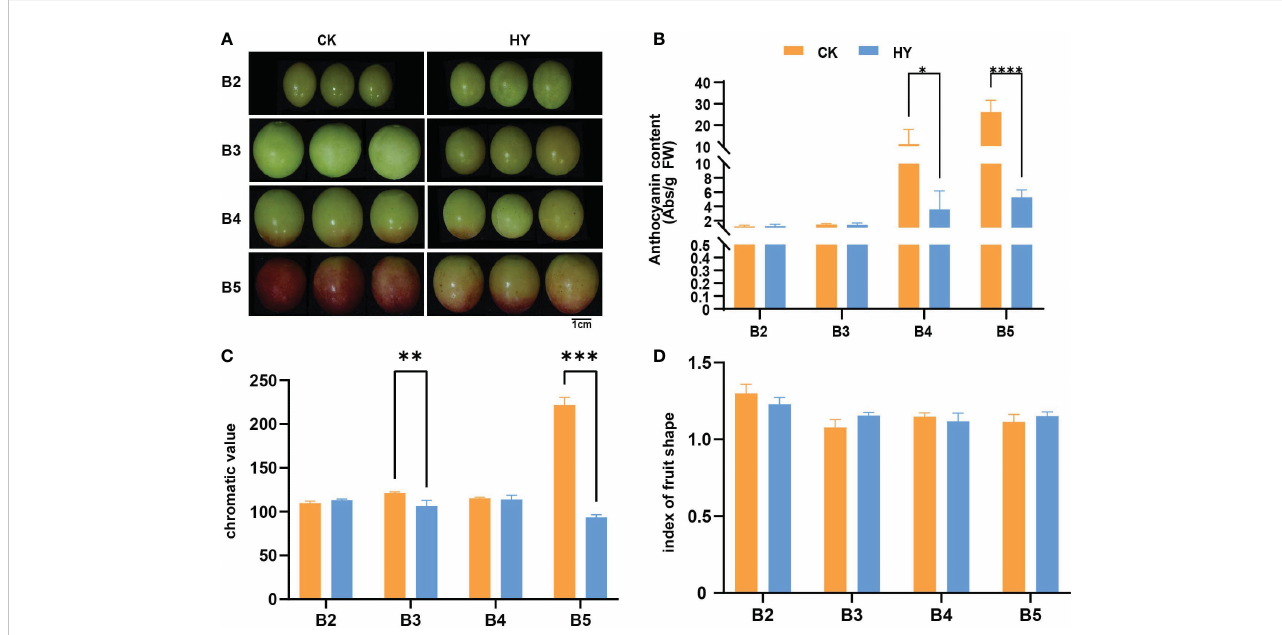
FIGURE 1 Phenotypic map of Gemstone seedless grape during fruit development when it was treated with the control and hyperoside(HY) treatments. (A) A representation of grape fruits in their young, late, and mature phases after being treated with hyperoside and under control. (B) The amount of anthocyanin in grape fruits at various growth stages and after various treatments. (C) The chroma value of grape fruits at various growth stages when subjected to various treatments. (D) The grape fruit form index at various growth stages under different treatments. The statistics re fl ect the mean ± SD of three biological replicates. Statistical signi fi cance: *P < 0.05; ***P < 0.01. **0.01<P<0.05,